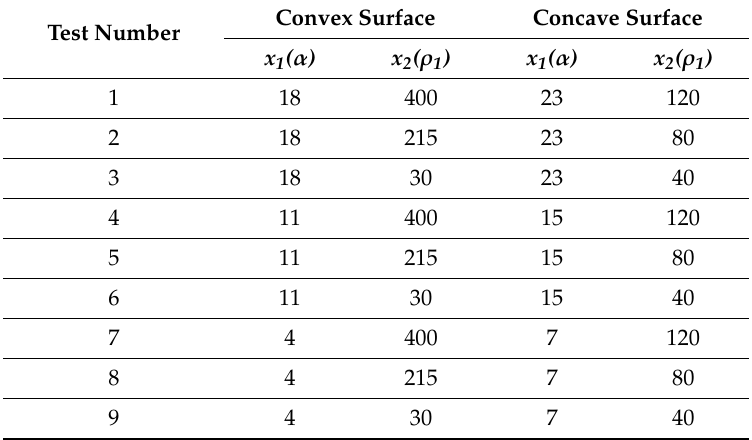
Table 6. Studies’ plan for the convex and concave surface of the turbine